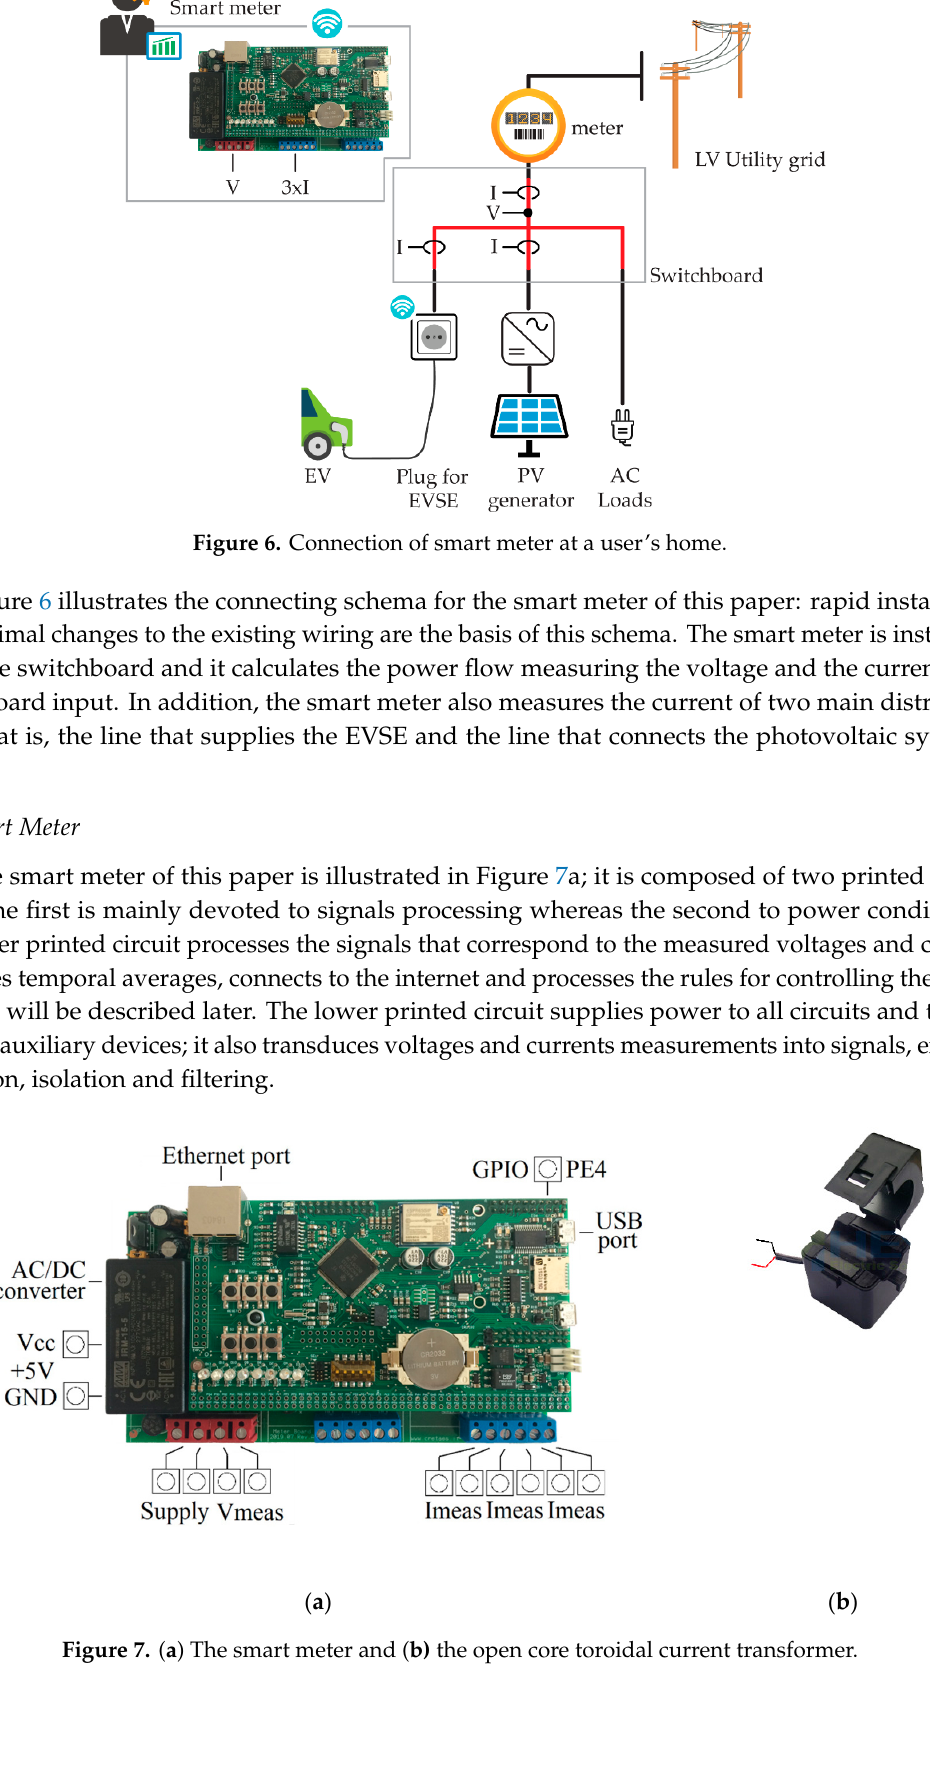
Figure 7. ( a ) The smart meter and ( b) the open core toroidal current transformer.